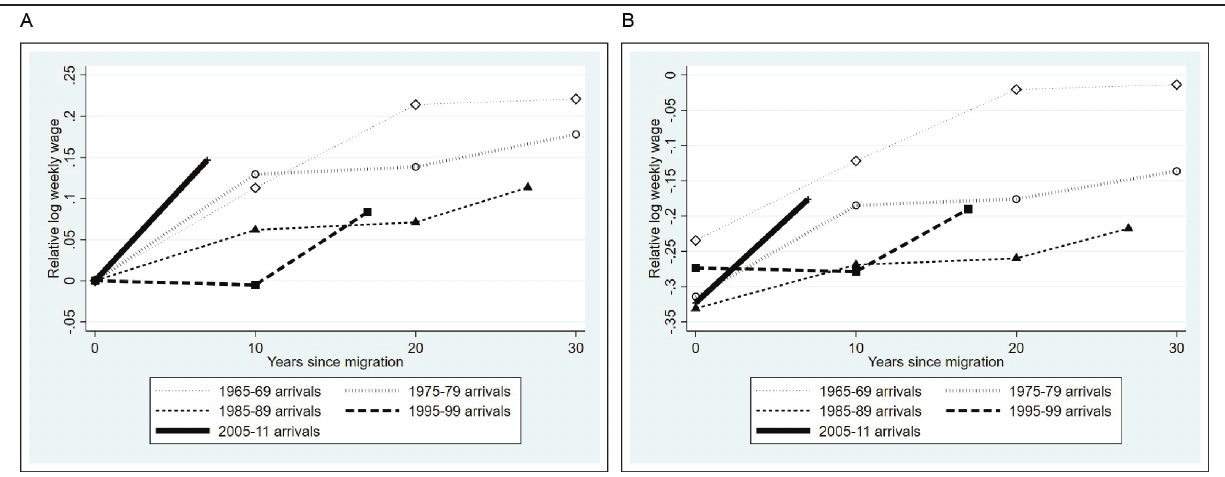
Figure 1 Age-adjusted convergences for the relative log weekly earnings of immigrant cohorts from all countries of origin: (A) normalized convergence; (B) initial gaps and